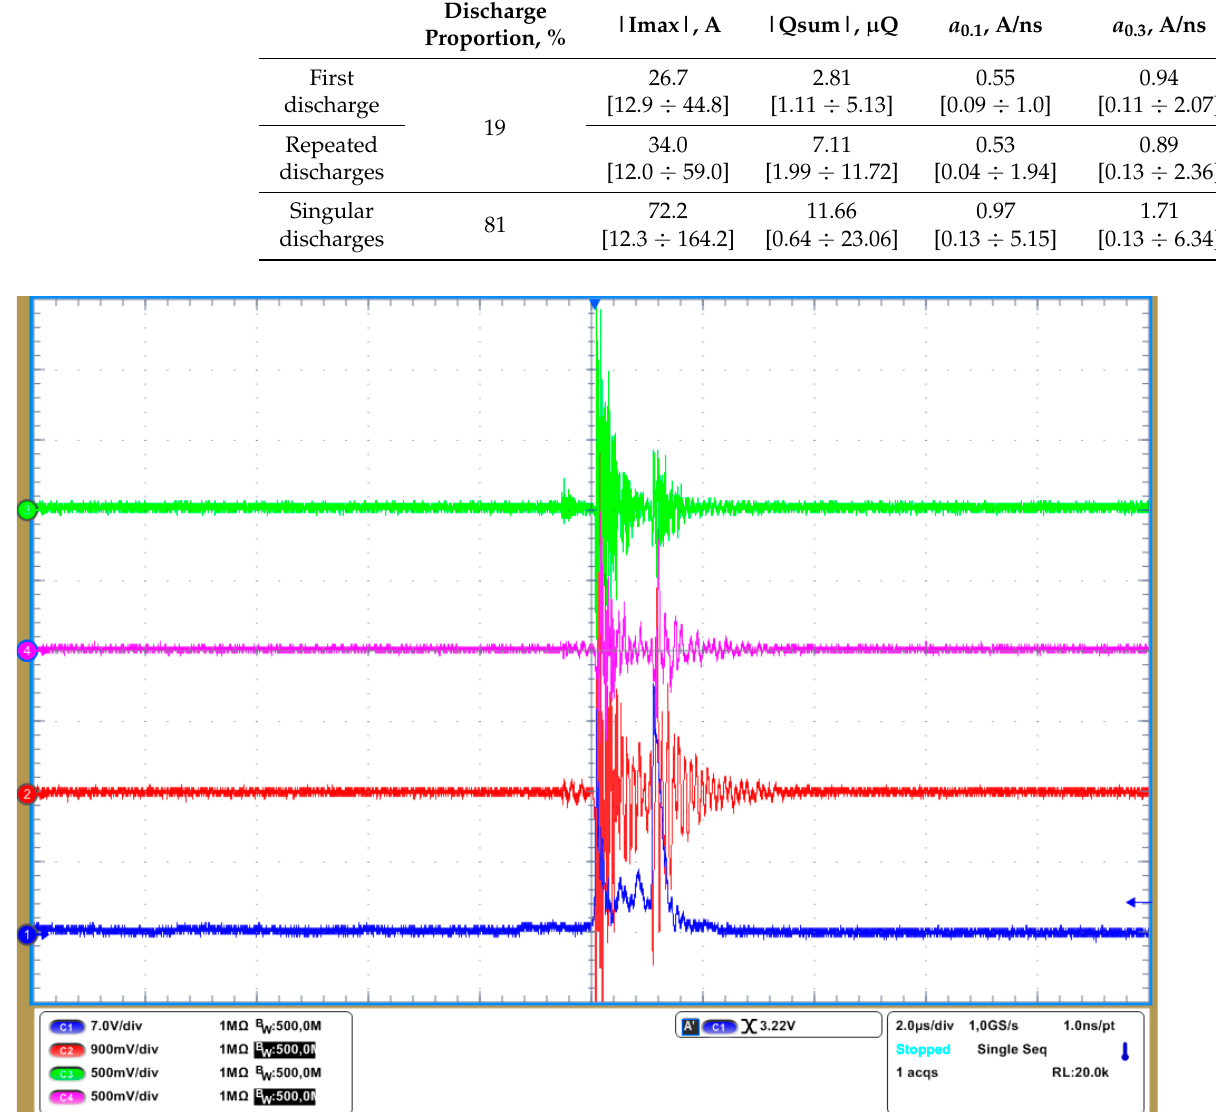
Figure 6. Characteristic oscillogram of the first and repeated discharge current pulses (blue signal) between a single artificial positively charged thundercloud cell and the ground involving two groups of model hydrometeors and signals, registered by antennas A1–A3 (red, green and magenta signals resp.).